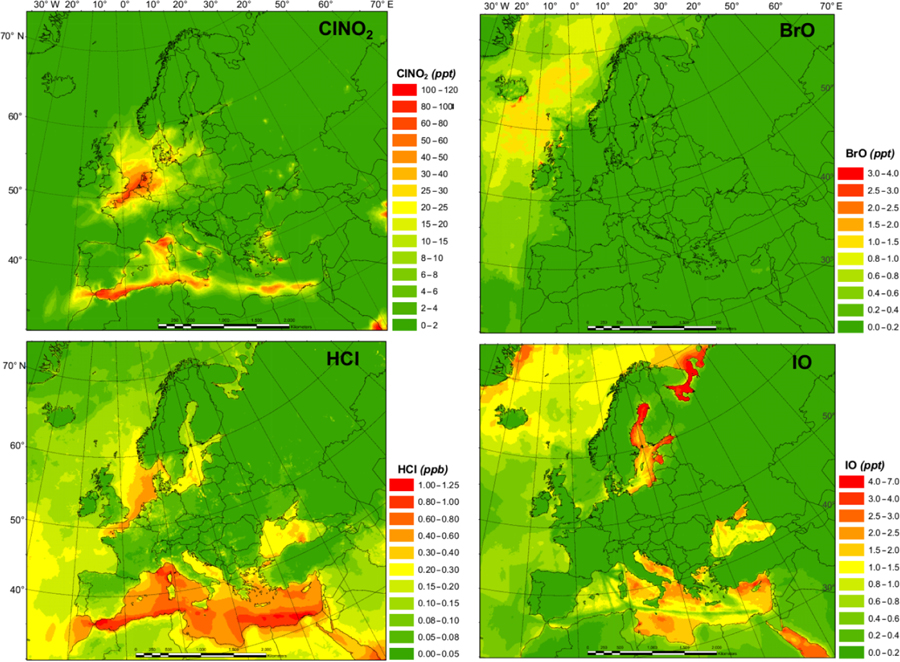
Monthly average ClNO2, HCl, BrO, and IO concentration in the HAL simulation.